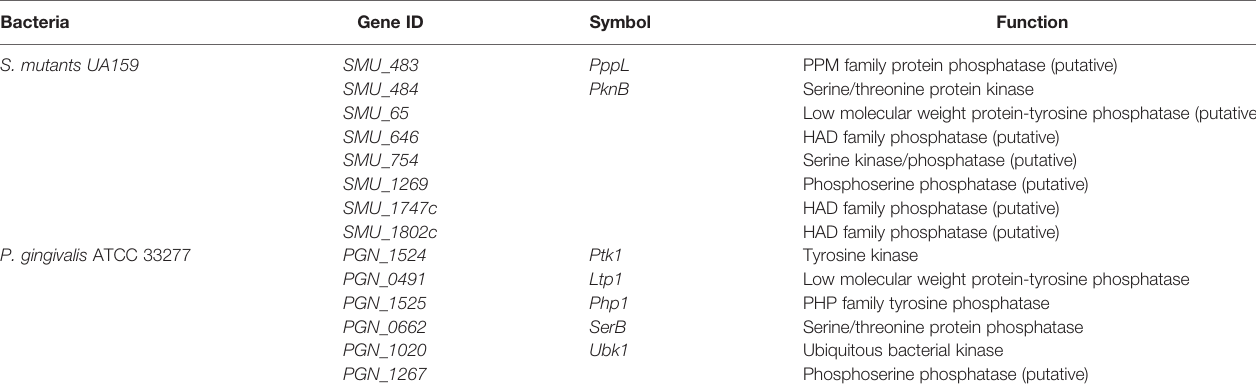
TABLE 2 | Tyrosine and serine/threonine kinases and phosphatases in S. mutants and P. gingivalis . Bacteria Gene ID